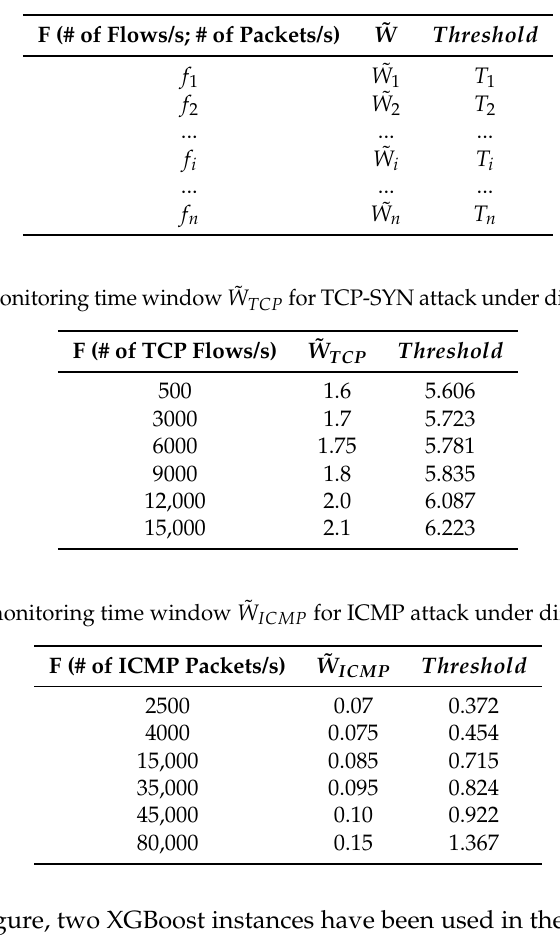
Table 3. Reference table with optimized monitoring time window (MTW) and threshold for given traffic scenarios.